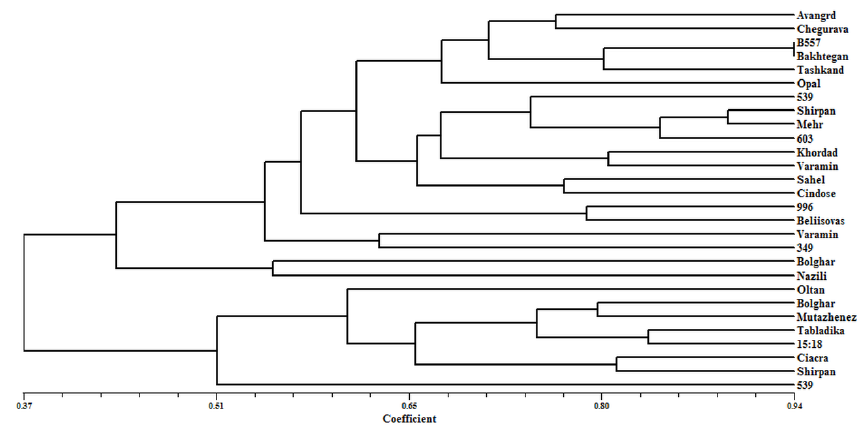
Fig. 4. Phenogram showing genetic diversity among 28 cotton cultivars using ISSR data